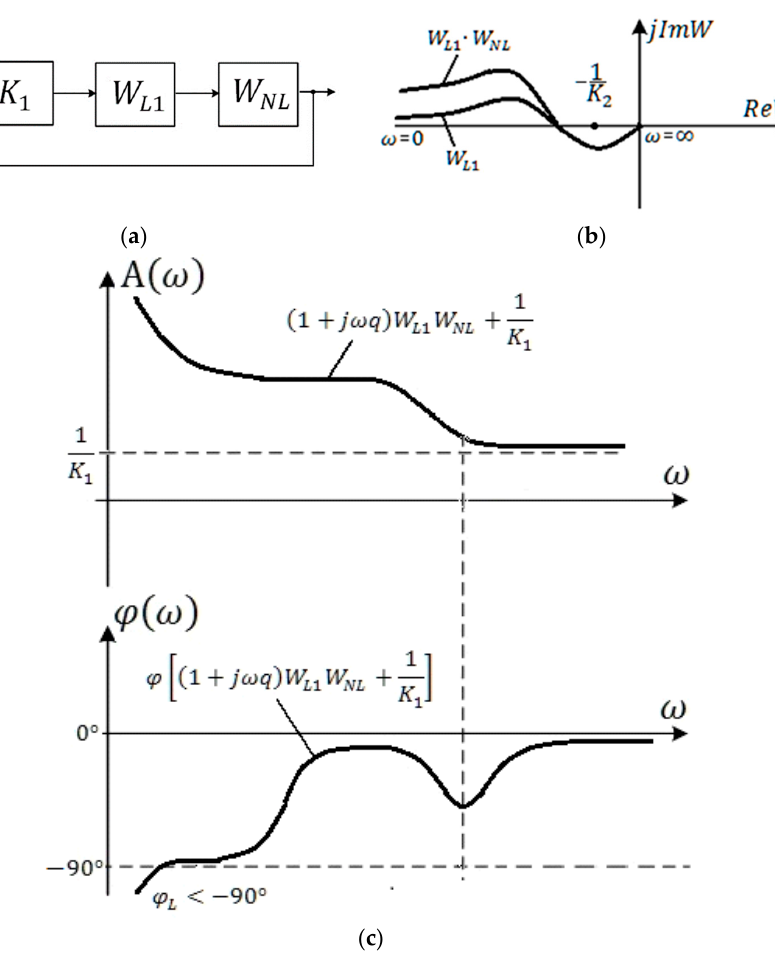
Figure 15. Structure of nonlinear ACS ( a ) and stability condition for it according to the criterion of V.M. Popov for frequency hodographs ( b ) and logarithmic frequency characteristics ( c ), which is not fulfilled for any K.